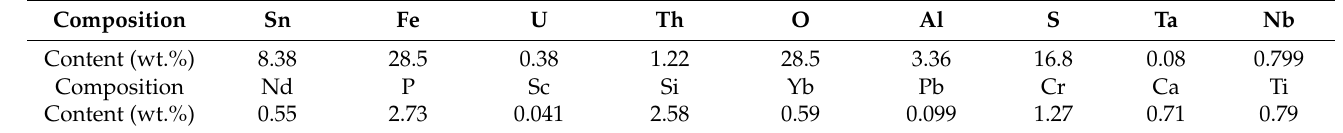
Table 2. Detection of composition content in tantalum-niobium slag by XRF.